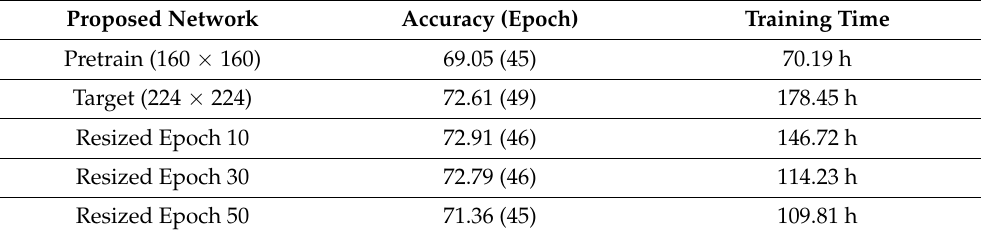
Table 3. Performance evaluation of the proposed